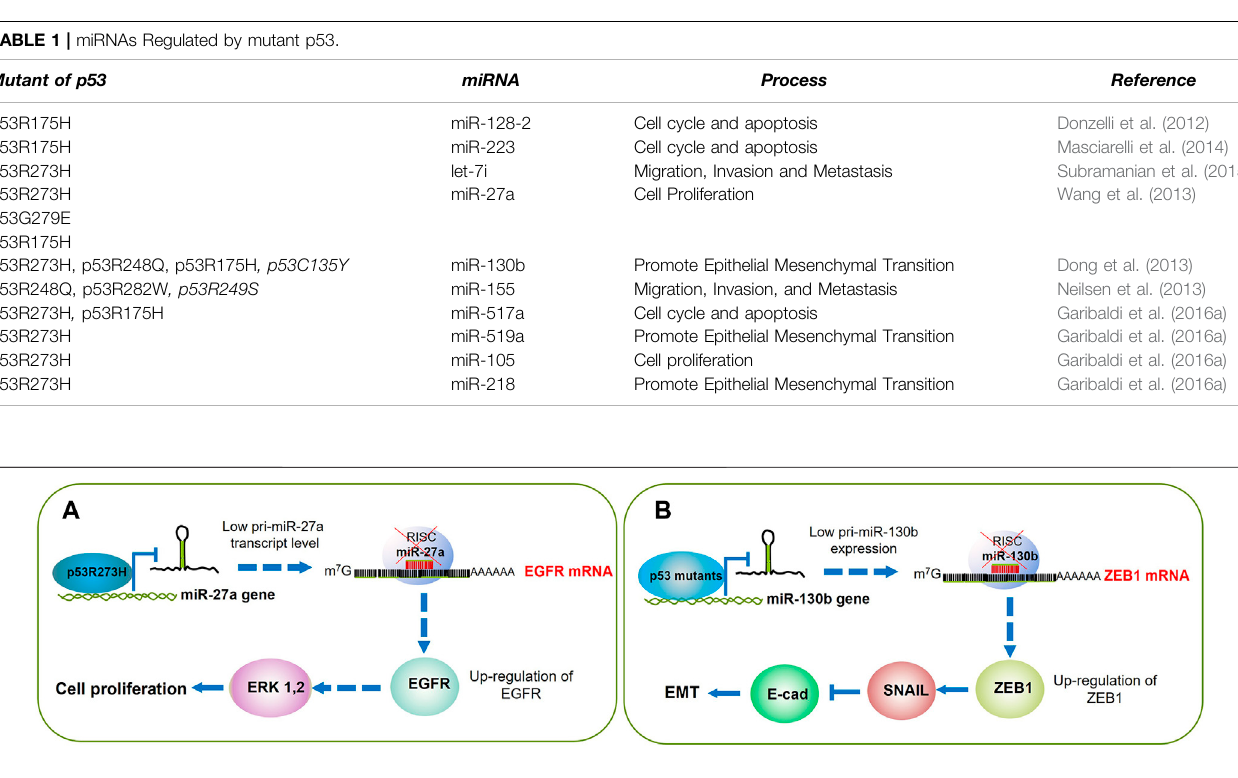
Frontiers in Cell and Developmental Biology |